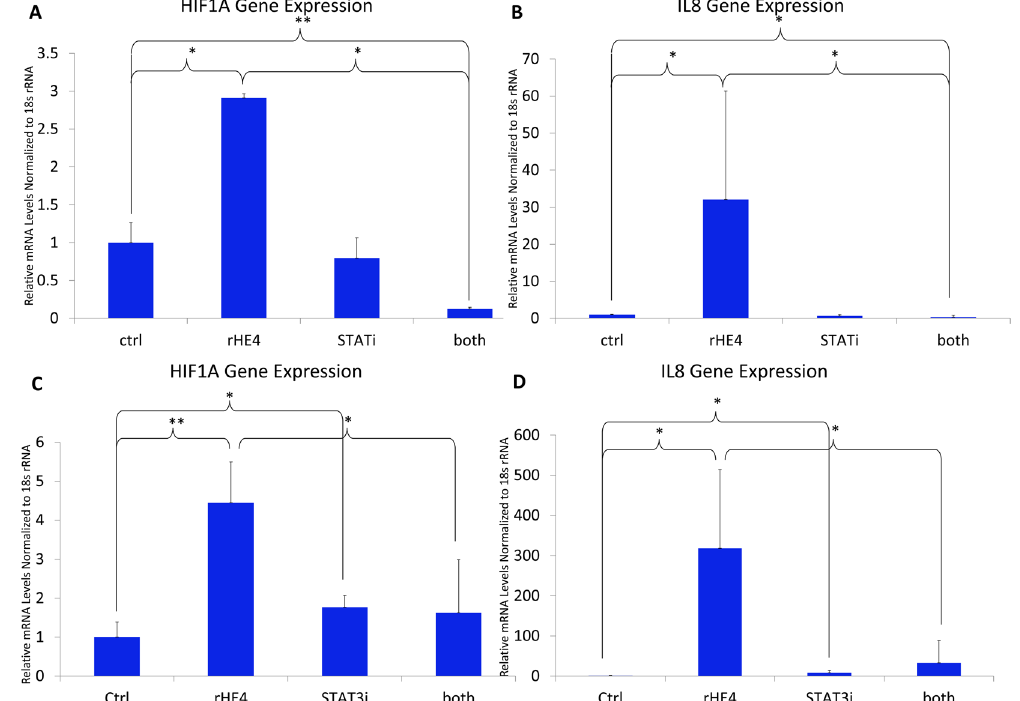
Figure 2. HE4-mediated upregulation of IL8 and HIF1A gene expression is suppressed by STAT3 inhibition in PBMC ( A ) qPCR revealed upregulation of HIF1A in PBMC treated with rHE4 for 6 h, which was blocked by treatment with a STAT3 inhibitor. (B) Upregulation of IL8 in PBMC treated with rHE4 for 6 h, which was blocked by treatment with a STAT3 inhibitor. (C) Upregulation of HIF1A in PBMC treated with rHE4 for 24 h, which was blocked by treatment with a STAT3 inhibitor. (D) Upregulation of IL8 in PBMC treated with rHE4 for 24 h, which was blocked by treatment with a STAT3 inhibitor. Error bars represent standard deviation. * p < 0.05. Results are the average of ≥ 3 biological